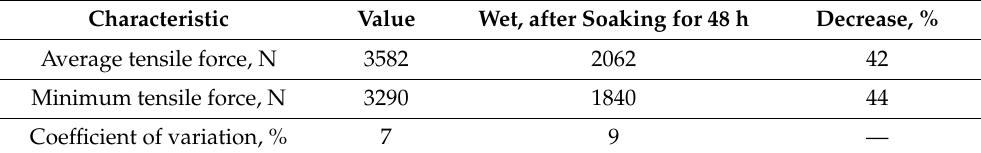
Table 3. Tensile test results for LVL panels.